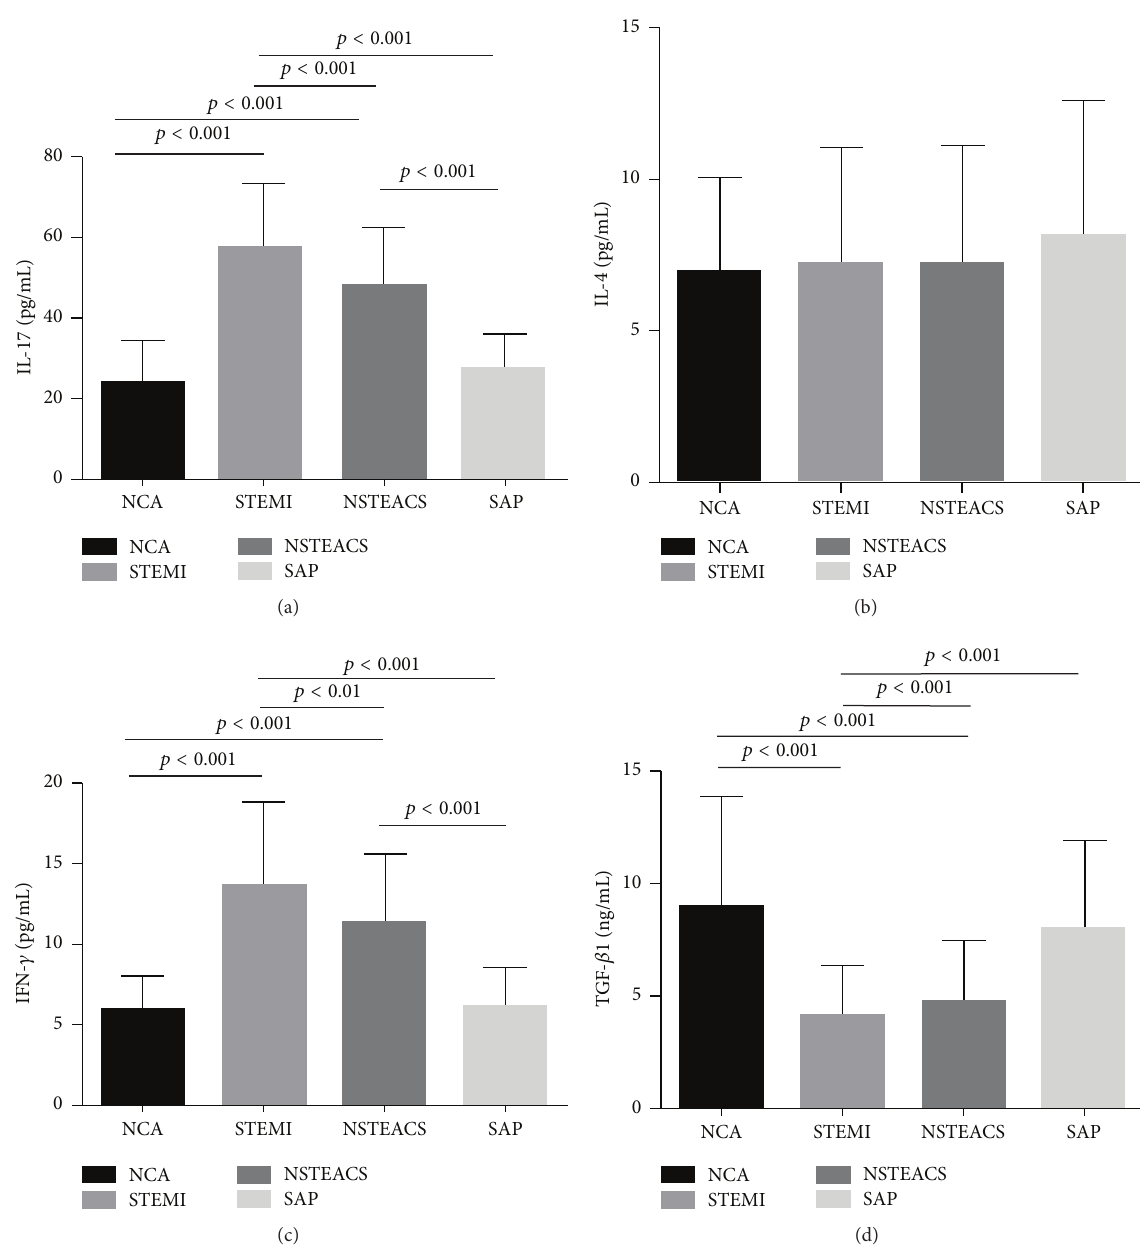
Figure 2: Cytokine concentrations in the four groups. (a) The IL-17 and IFN- 𝛾 concentrations in patients with STEMI and NSTEACS were significantly higher compared with those in patients with SAP and control (Figures 2(a) and 2(c)). (b) IL-4 concentrations showed no difference in any of the groups (Figure 2(b)). (c) TGF- 𝛽 1 concentrations in patients with STEMI and NSTEACS were significantly lower than those in patients with SAP and control (Figure